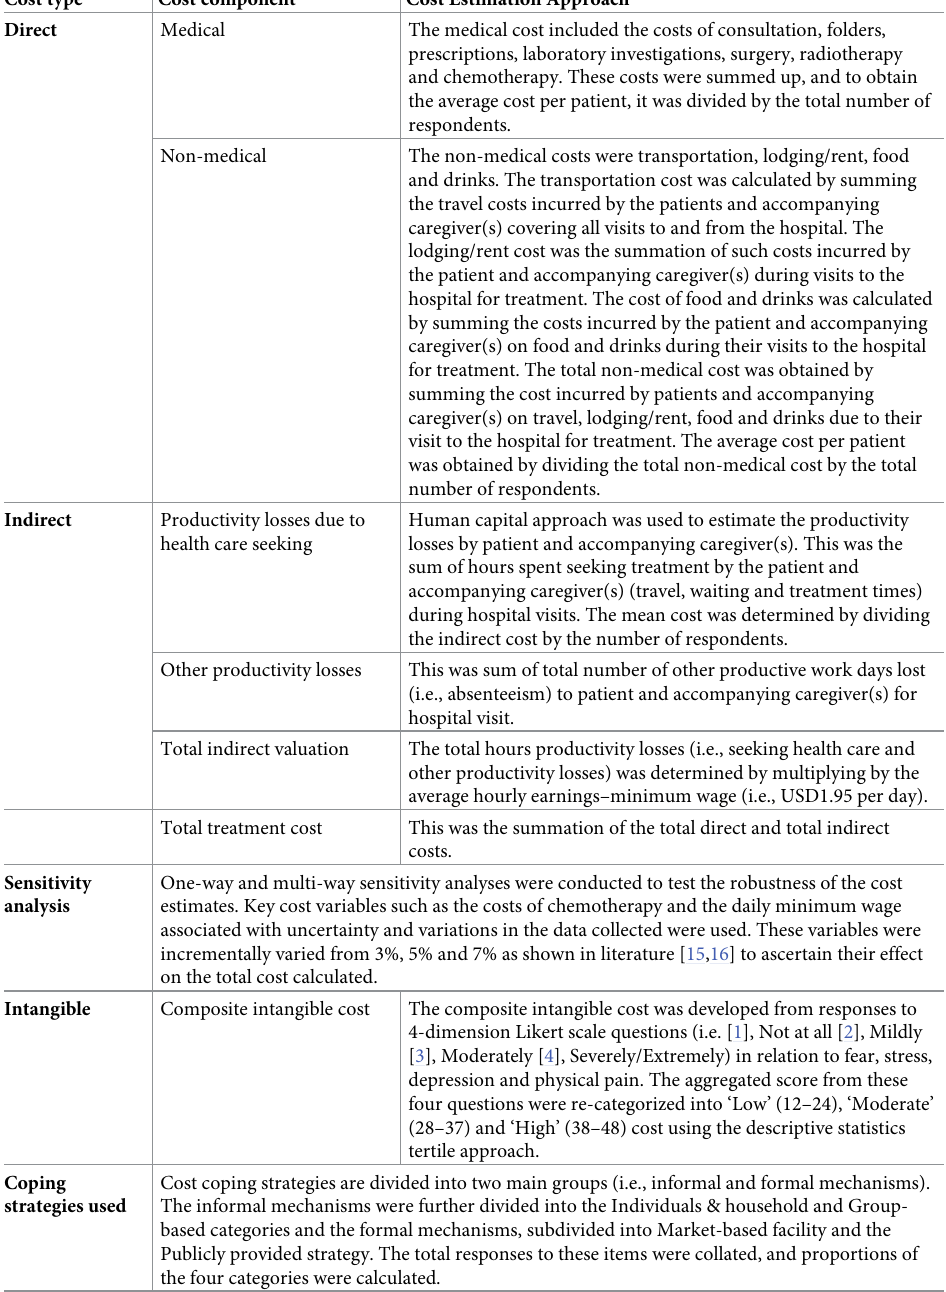
Table 1. Breast cancer treatment cost and cost coping